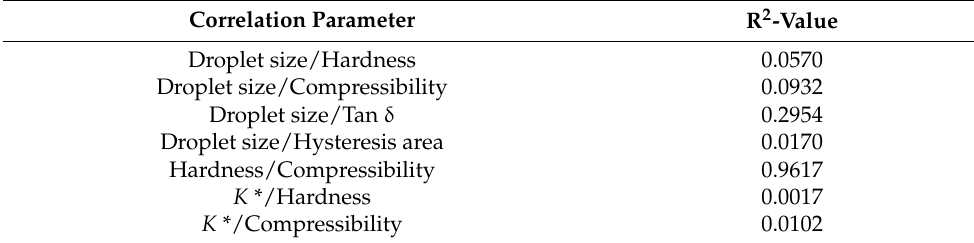
Table 2. Correlation between rheological (consistency index, hysteresis area and tan δ ), mechanical properties (hardness and compressibility) and droplet size of emulgels systems composed of polymers (C934P, C974P, PC), different vegetable oils (PF, AN) and bioactive agent combinations (PE, CUR, PE+CUR) at 25 ◦